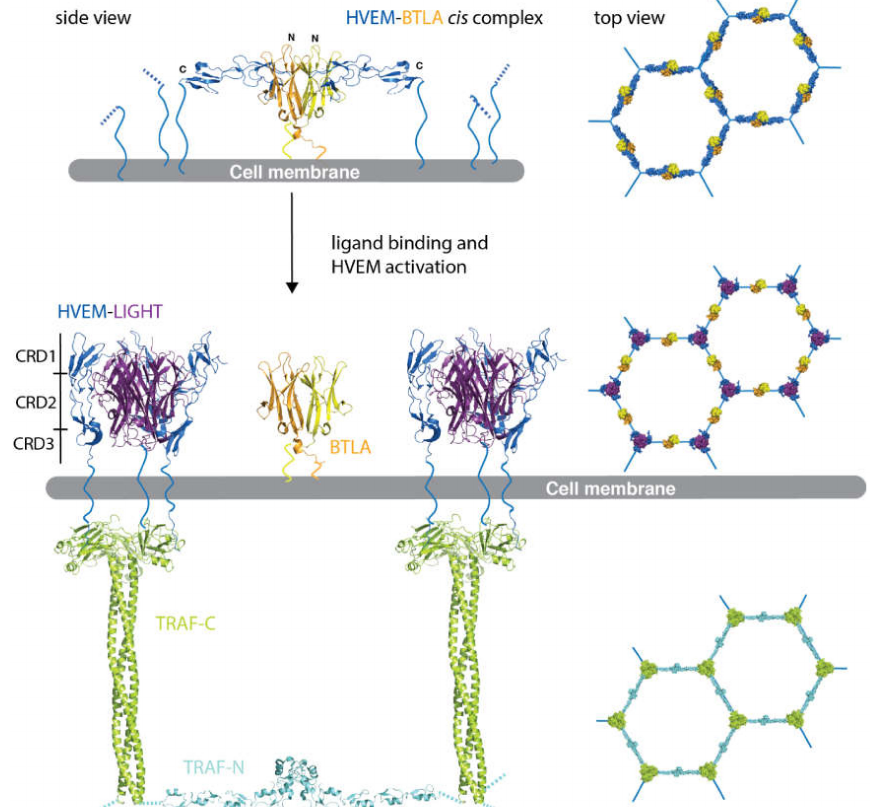
Figure 3. Regulation of herpes virus entry mediator (HVEM) signaling by B- and T lymphocyte attenuator (BTLA). The structure of the HVEM-BTLA cis complex (based on PDB ID: 2AW2) is shown in side view in cartoon representation (top left). The HVEM monomers are shown in blue and monomers of the BTLA dimer in yellow and orange respectively. BTLA aids the oligomerization of HVEM. The complexes may arrange in a hexagonal lattice shown on the right in surface representation (top view). Trimeric LIGHT binding to HVEM activates the receptors to form the LIGHT-HVEM complexes shown in cartoon representation (PDB ID: 4RSU). LIGHT is shown in magenta and HVEM in blue. The CRD1-3 are labelled in the left complex. The receptor ligand complexes may also cluster to form a hexagonal lattice shown on the right in top view. The HVEM-LIGHT complexes are bound to TNF related associated factor (TRAF) in the cytosol shown in chartreuse. TRAF trimerization is initiated by LIGHT binding and HVEM activation. This then leads to the dimerization of the TRAF-N domain shown in cyan. The TRAF complexes also form a hexagonal lattice shown on the right in surface representation. The TRAF complex was modeled from several structures as described earlier